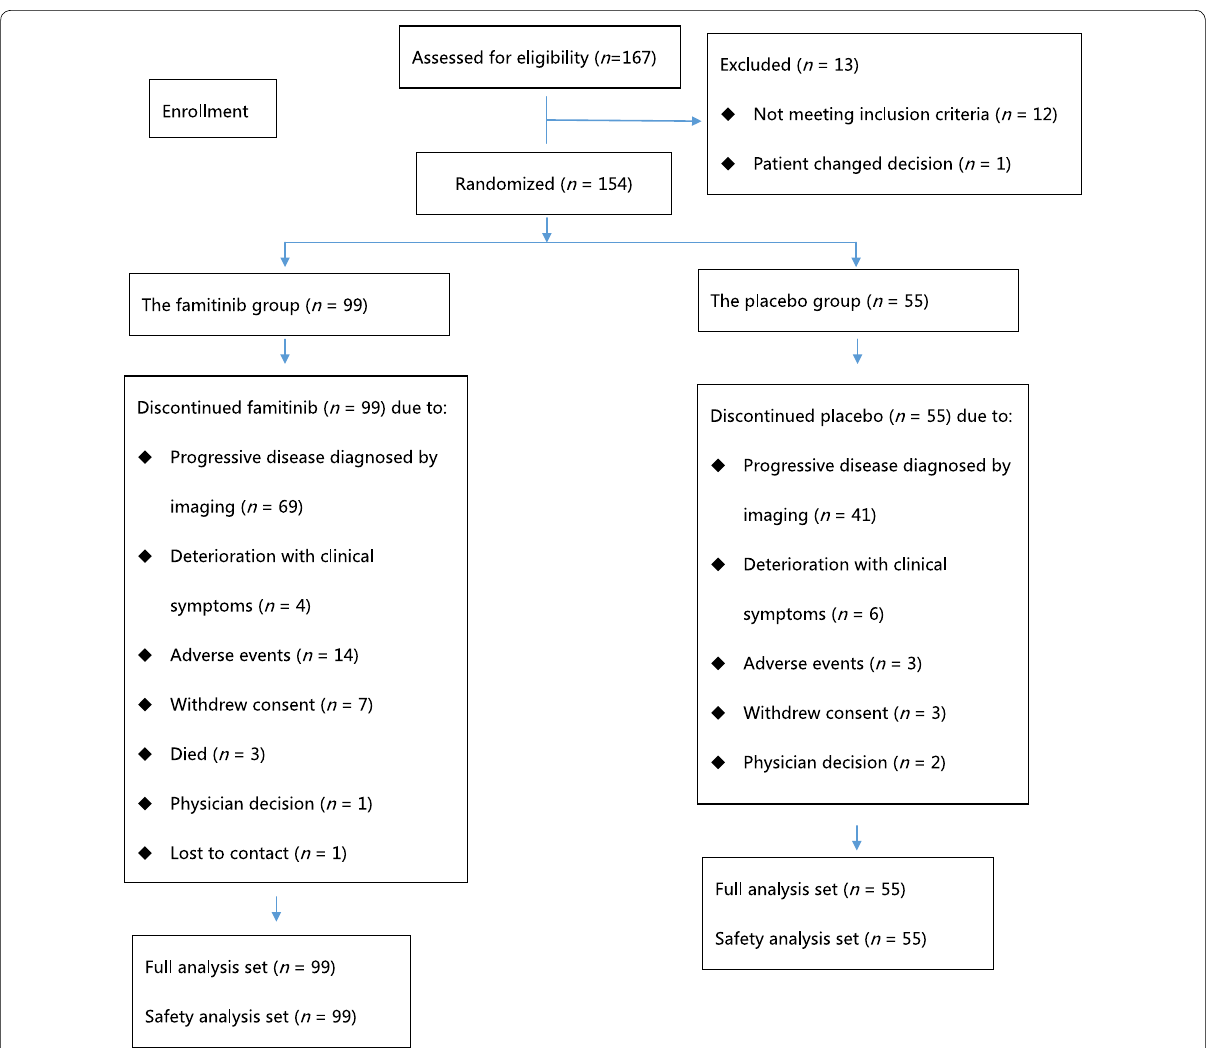
Fig. 1 The flow diagram of patient enrollment for the phase II clinical trial of famitinib versus placebo in the treatment of refractory metastatic colorectal cancer